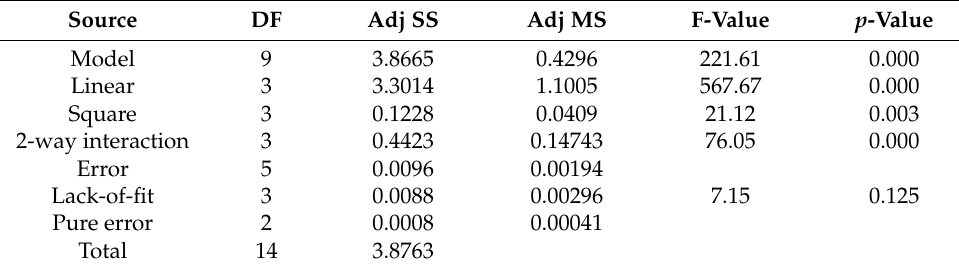
Table 3. ANOVA for MRR in PMECDM.